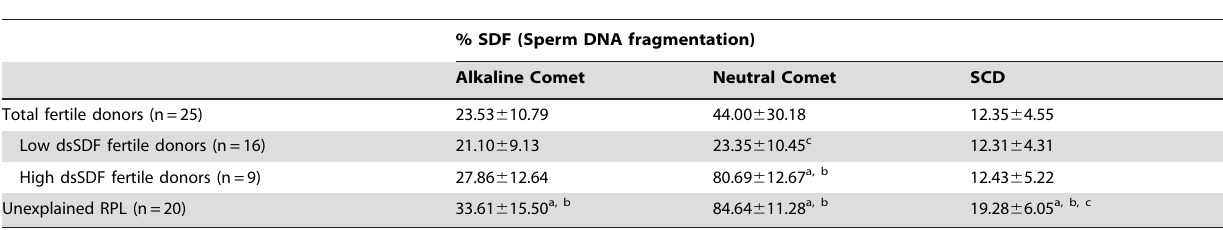
Table 1. Sperm DNA fragmentation (mean 6 SD) in fertile donors and unexplained RPL samples.